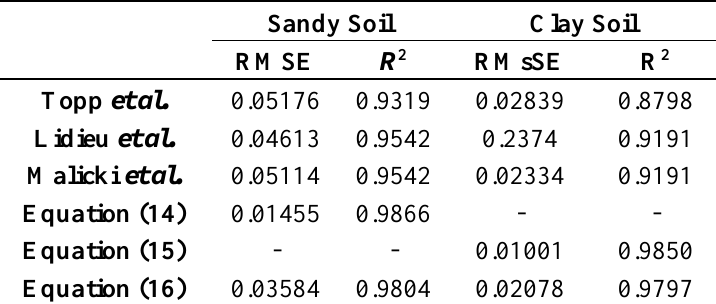
Table 3. Results from the comparison of